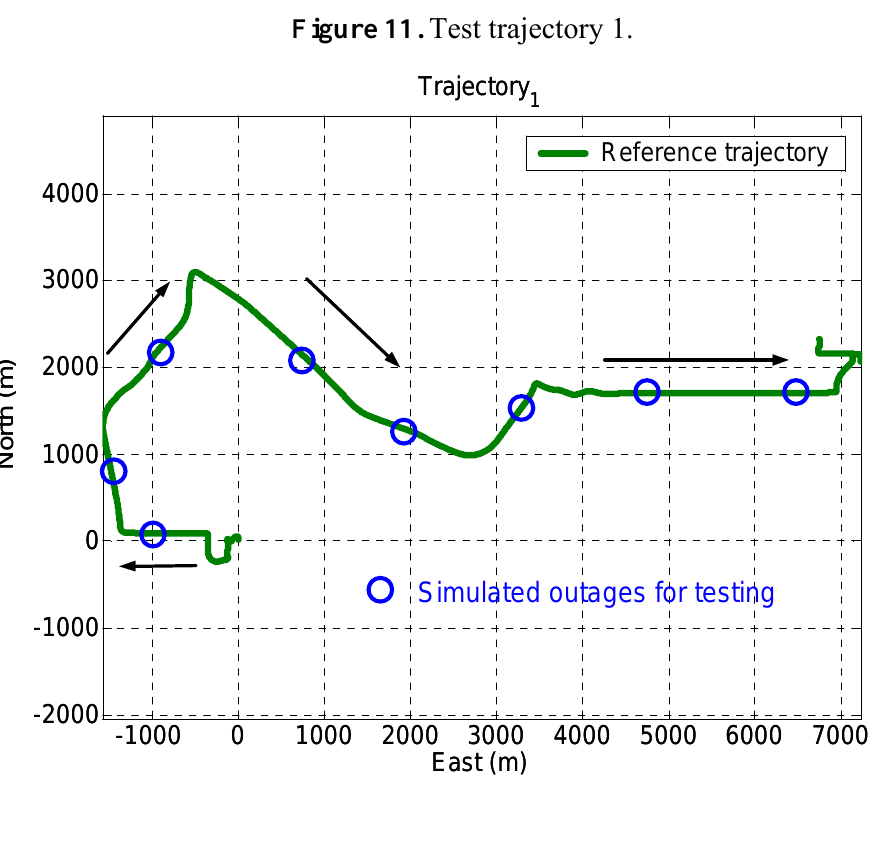
Figure 11. Test trajectory